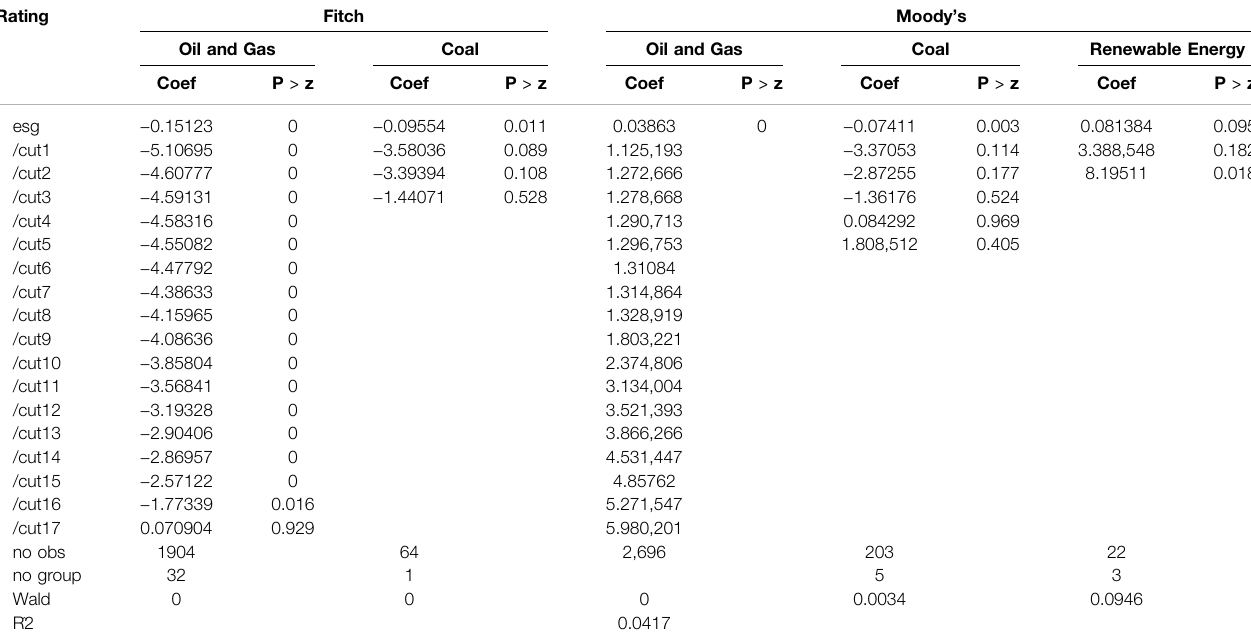
TABLE 5 | Impact of ESG factors on credit rating changes according to sector division and type of credit rating agency.